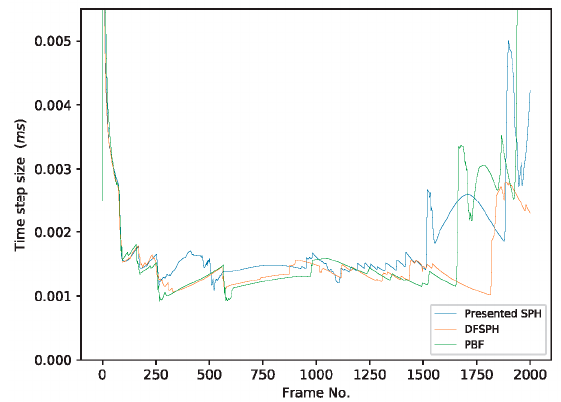
Figure 5. The time step statistics of the three methods in the first 2000 frames of dam break scene. Table 1. The average, maximum, and minimum time steps of the first 2000 frames; the experimental scene is dam